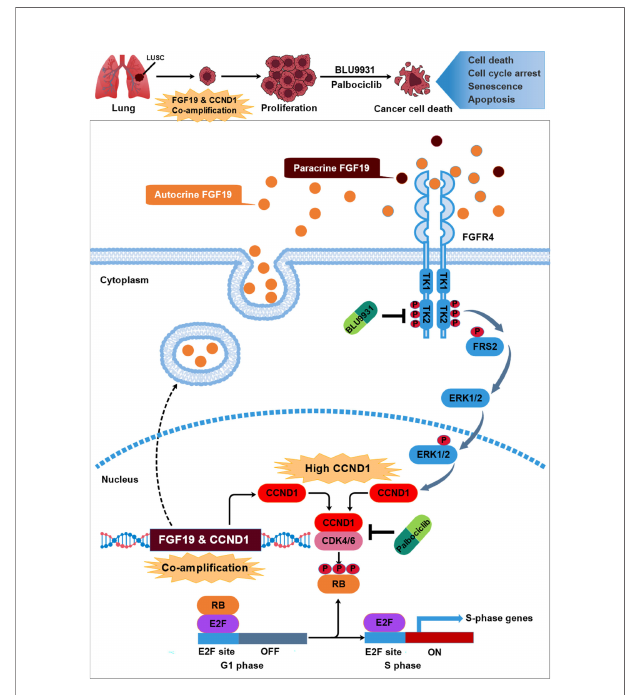
FIGURE 8 | The schematic model of this study: underlying mechanism that link neighboring oncogene FGF19 & CCND1 co-ampli fi cation in the development of LUSC. FGF19 was co-ampli fi ed and co-expressed with its neighboring gene CCND1 in a subset of LUSC. Overexpression of FGF19 activates FGFR4 and leads to phosphorylation of FRS2 and ERK1/2, which further strengthens the increase in CCND1 expression caused by ampli fi cation. These lead to the phosphorylation of RB by CCND1-CDK4/6 complex, causing unrestrained transcription factor E2F, which promotes cell cycle progression and lead to the malignant proliferation of LUSC. While co- targeting FGFR4 and CDK4/6 by BLU9931 and palbociclib potentiated the growth inhibition and arrested cells in G1